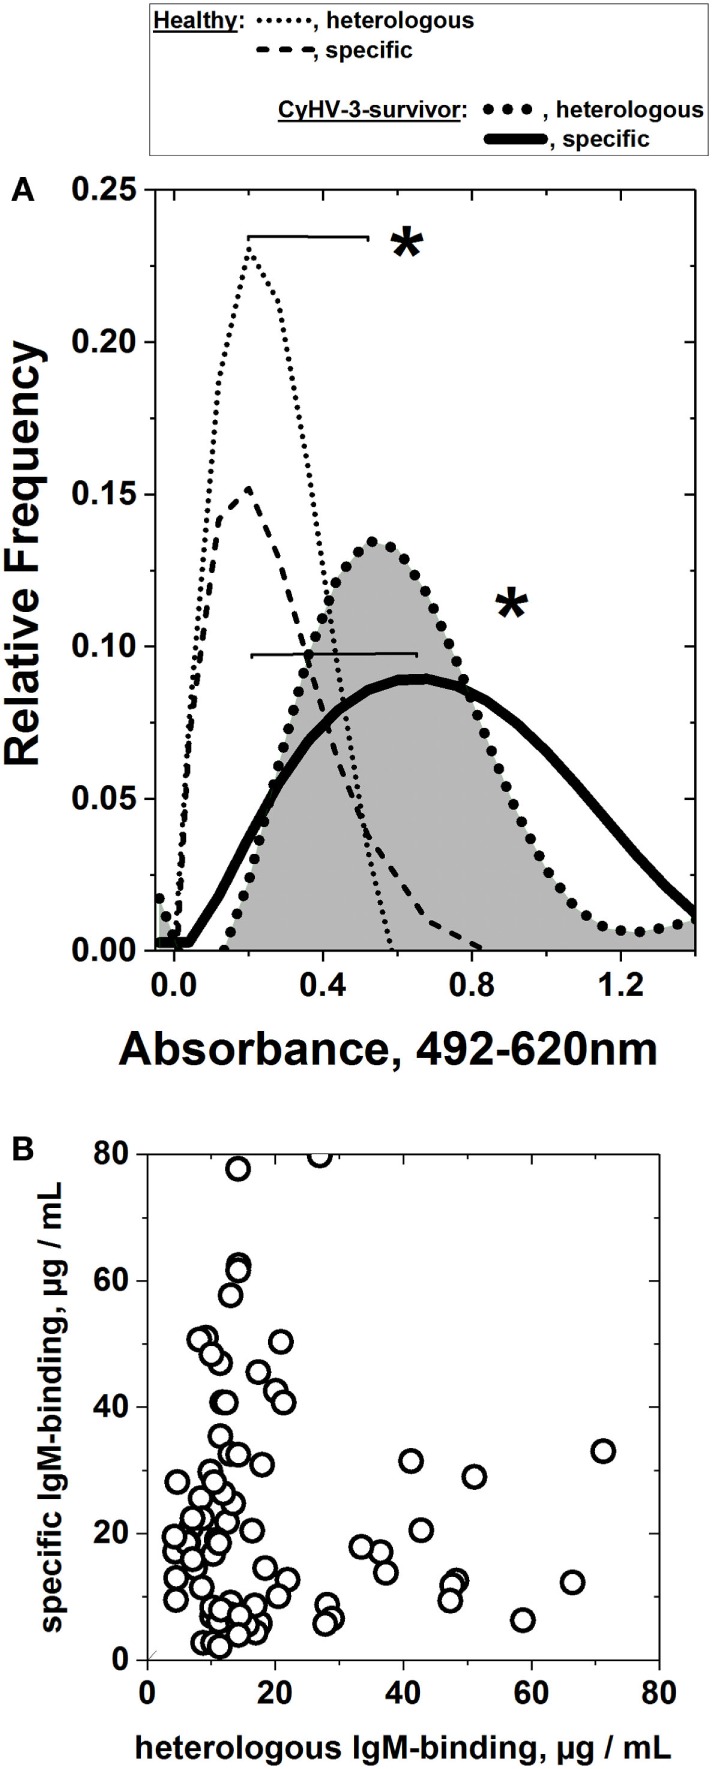
Heterologous and specific IgM binding of sera from cyprinid herpes virus 3 (CyHV-3) infection-survivor carp populations to consecutive frg11VHSV and frgIICyHV-3. Individual serum was obtained from CyHV-3 infection-survivors and healthy carp populations, diluted 100-fold and assayed in the same plate by consecutive frg11VHSV + frgIICyHV-3 enzyme-linked immunosorbent assay (scheme in Figure 3). Two micrograms of recombinant frg11VHSV or frgIICyHV-3 were used as solid phases. Heterologous and specific IgM binding of sera from carp surviving infection with CyHV-3 was estimated after preincubation of the sera with E. coli extract at an optimal concentration to lower to ~0.2 absorbance units the mean IgM binding of sera from the healthy carp population. Each raw absorbance value was normalized by the formula, raw individual absorbance value × 0.2/mean of healthy sera (n = 65). The IgM binding assays were repeated two to three times and their individual means used for further calculations. After normalization, the values were distributed in 0.08 absorbance classes and polynomically fitted, as indicated in Section “Materials and Methods.” *Statistically significant differences at the p < 0.05 level (Student’s t-test). (A) Heterologous and specific IgM binding of sera from the CyHV-3 infection-survivor carp population. Dotted black line (gray surface)—heterologous IgM binding of sera from the CyHV-3 infection-survivor carp population to frg11VHSV (n = 91). Black line—specific IgM binding of sera from the CyHV-3 infection-survivor carp population to frgIICyHV-3 (n = 91). Black dotted and dashed lines—heterologous and specific IgM binding from the healthy carp sera population, respectively, normalized to 0.2 absorbance means (n = 65). (B) Lack of correlation between heterologous (X-axis) and specific (Y-axis) IgM-binding concentrations from the individual sera from the CyHV-3 infection-survivor carp.